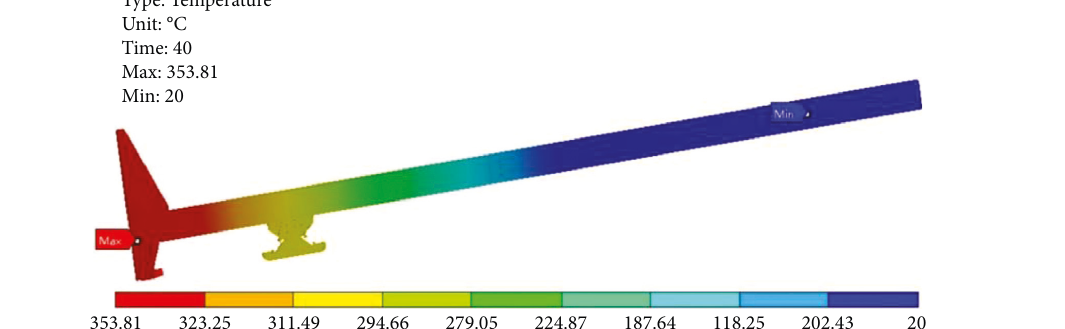
Figure 2: Temperature distribution of coke pusher.